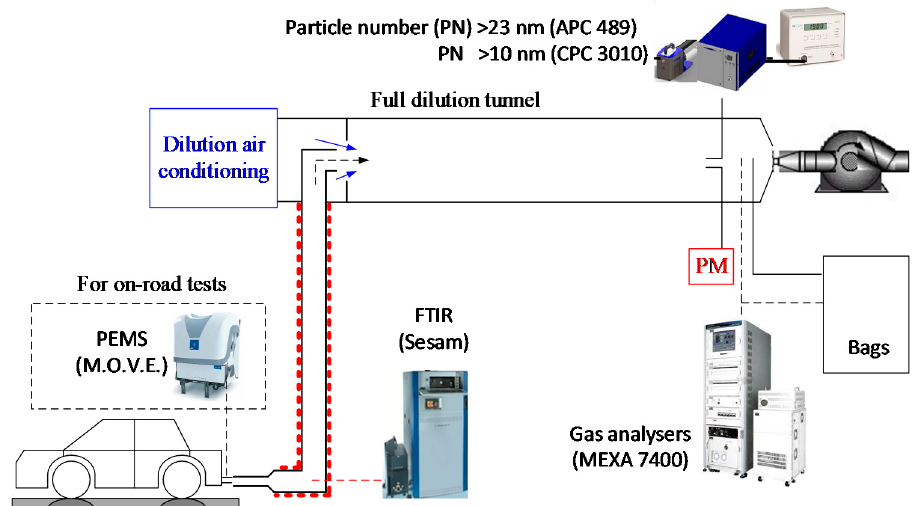
Figure 1. Experimental setup. APC = AVL Particle Counter; CPC = Condensation Particle Counter; FTIR = Fourier Transform Infrared Spectrometer; PEMS = Portable Emissions Measurement System; PM = Particulate Matter mass; PN = Particle Number.